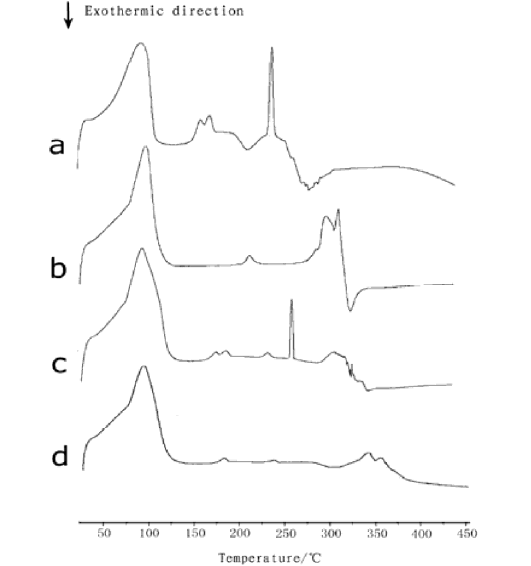
Figure 2. Differential scanning calorimetric (DSC) curves: ( a ) naringin; ( b ) β -cyclodextrin ( β -CD); ( c ) equimolecular physical mixture of naringin and β -CD; ( d ) inclusion complex of